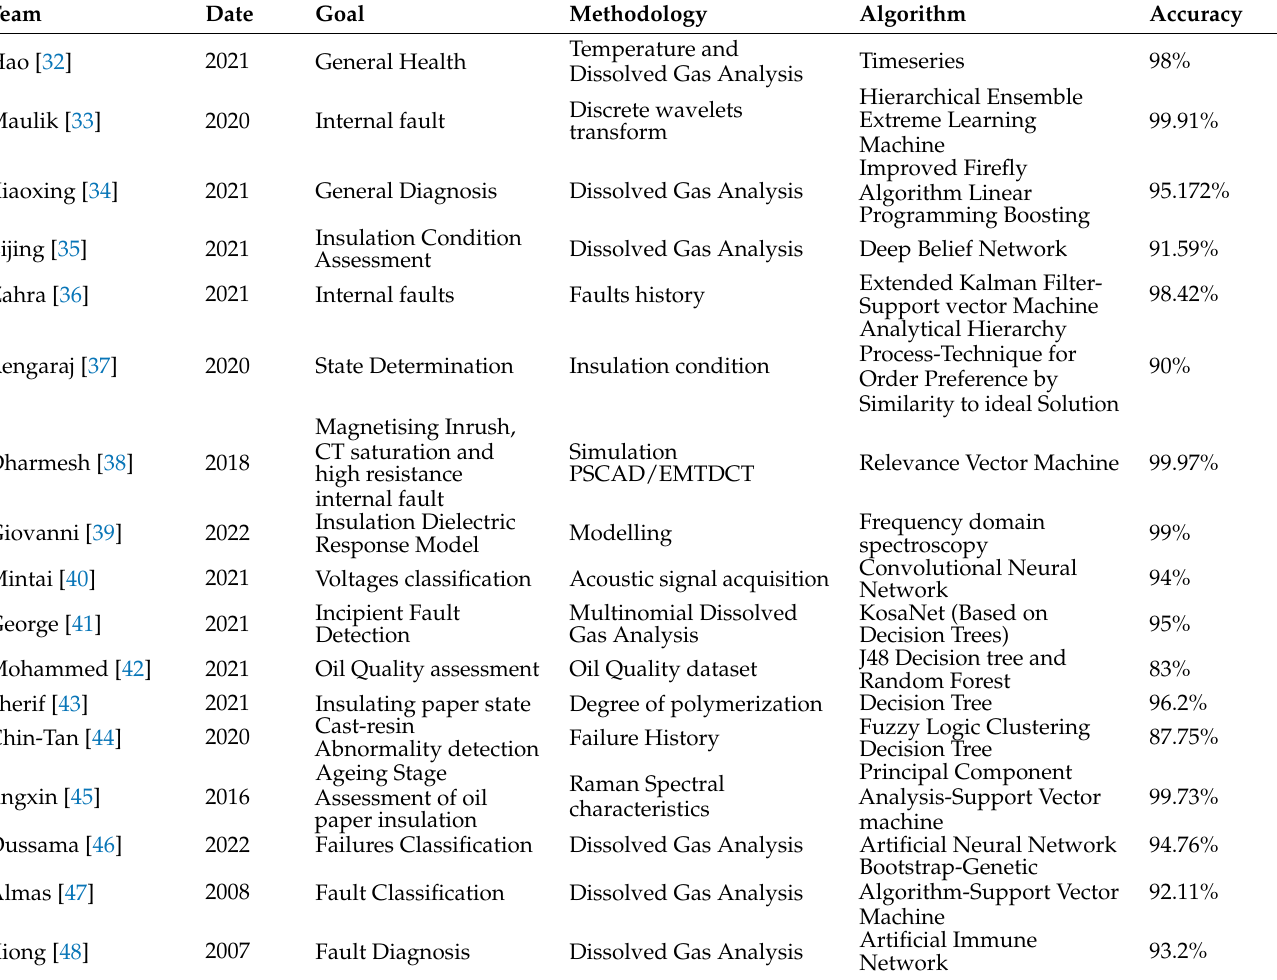
Table 1. State-of-the-art machine learning-based methodologies for power transformer diagnostics. Team Methodology Algorithm Accuracy